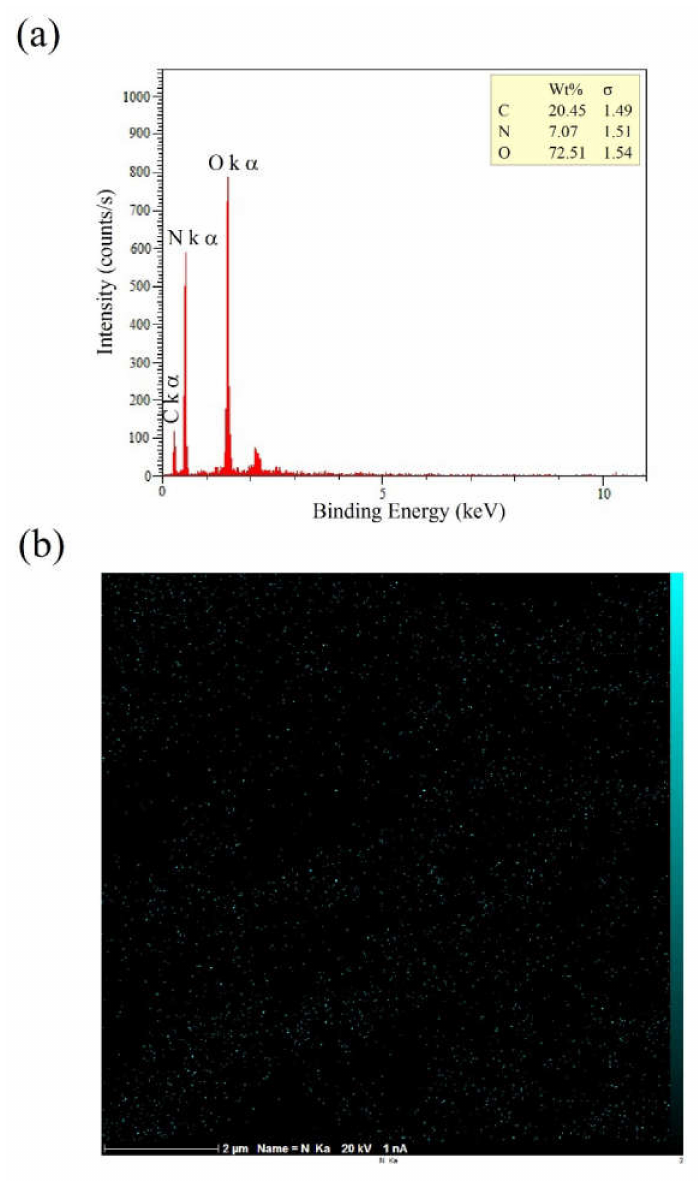
Figure 6. Energy-dispersive X-ray spectroscopy (EDXS) analysis results: ( a ) nitrogen-related peaks; ( b ) 2D elemental mapping of